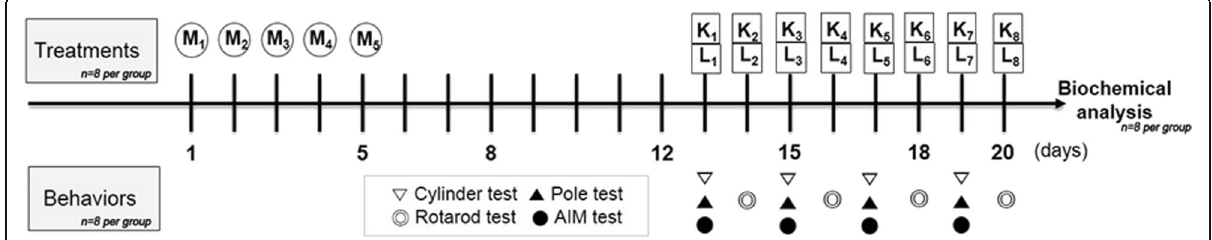
Fig. 1 Schematic representation of the experimental design. Each mouse received an injection of either saline or MPTP solution for 5 consecutive days. One week after the final injection, the mice were administered KD5040, L: L